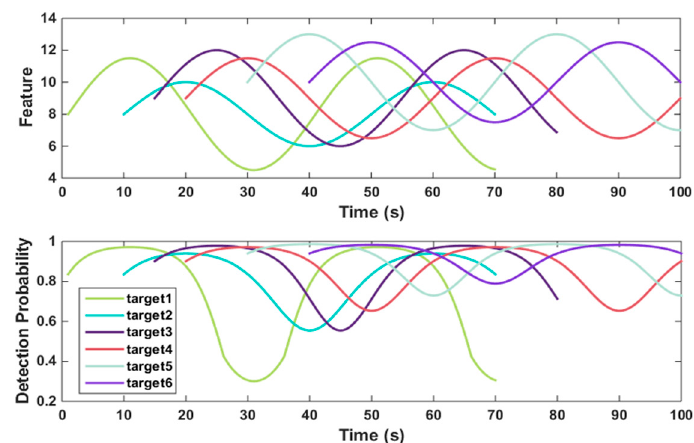
Figure 1. Truth trajectories of the target.